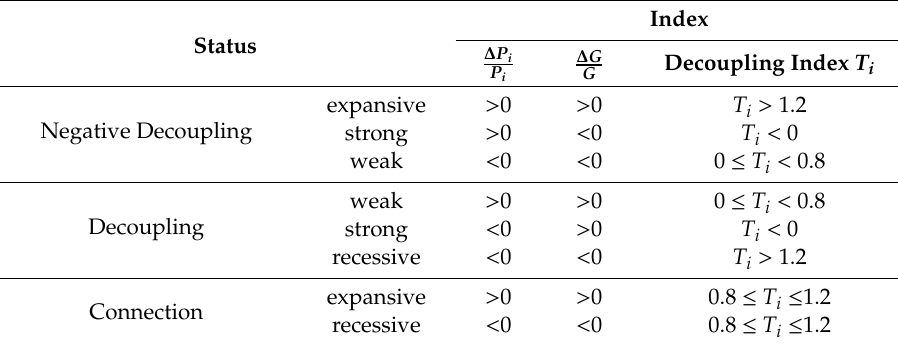
Table 5. Classification of decoupling index.